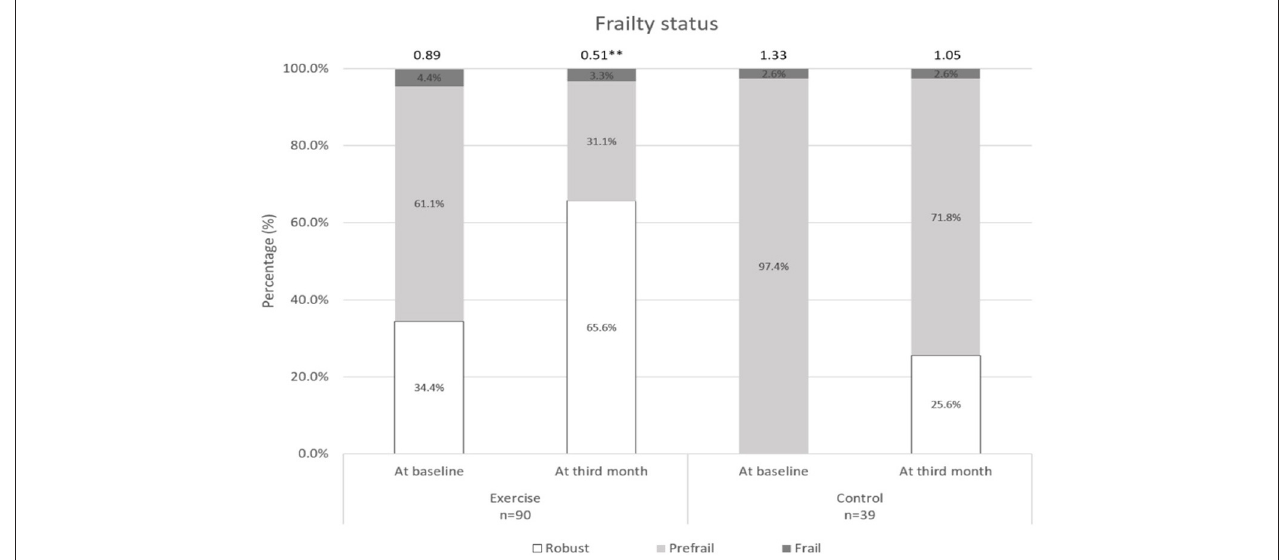
FIGURE 3 | Frailty status at baseline and third month. **indicates significant difference at p < 0.01 between baseline and third month.